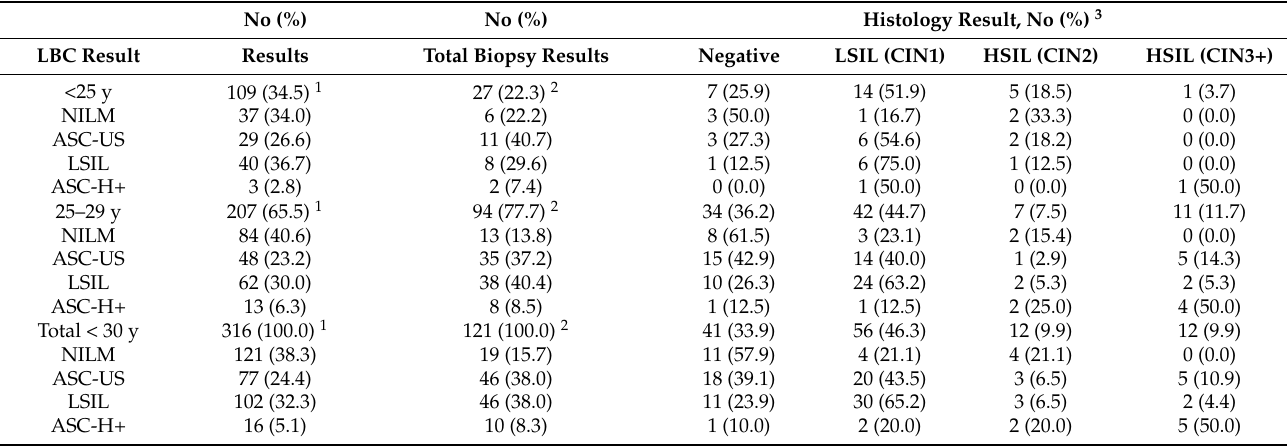
Table 6. Age-stratified biopsy results (<25, 25–29 and <30 years) with preceding LBC